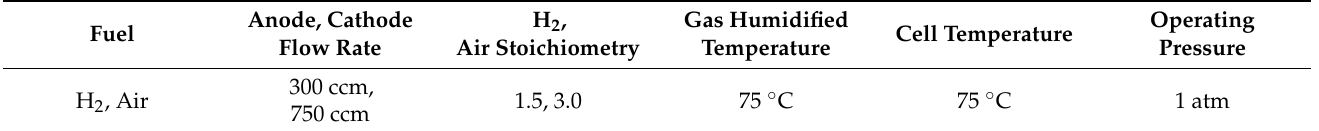
Table 5. Operating condition for the single cell.